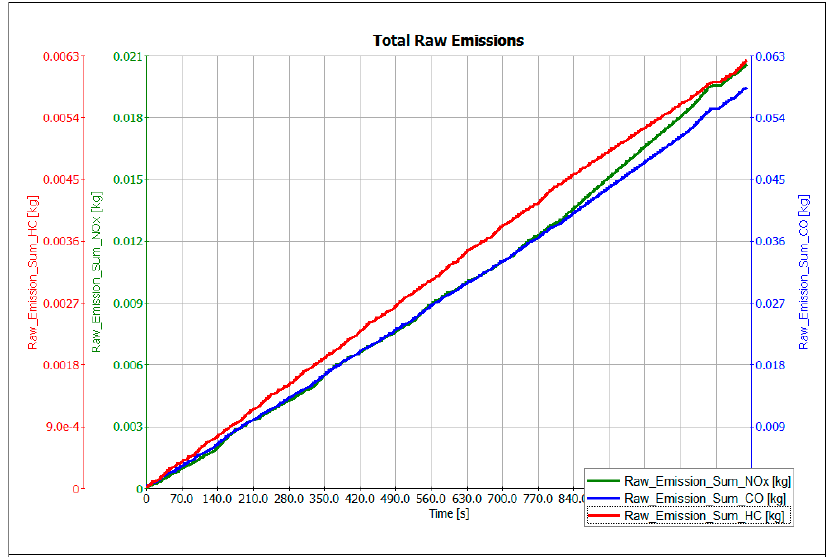
Figure 8. The emission curves under NEDC tests.